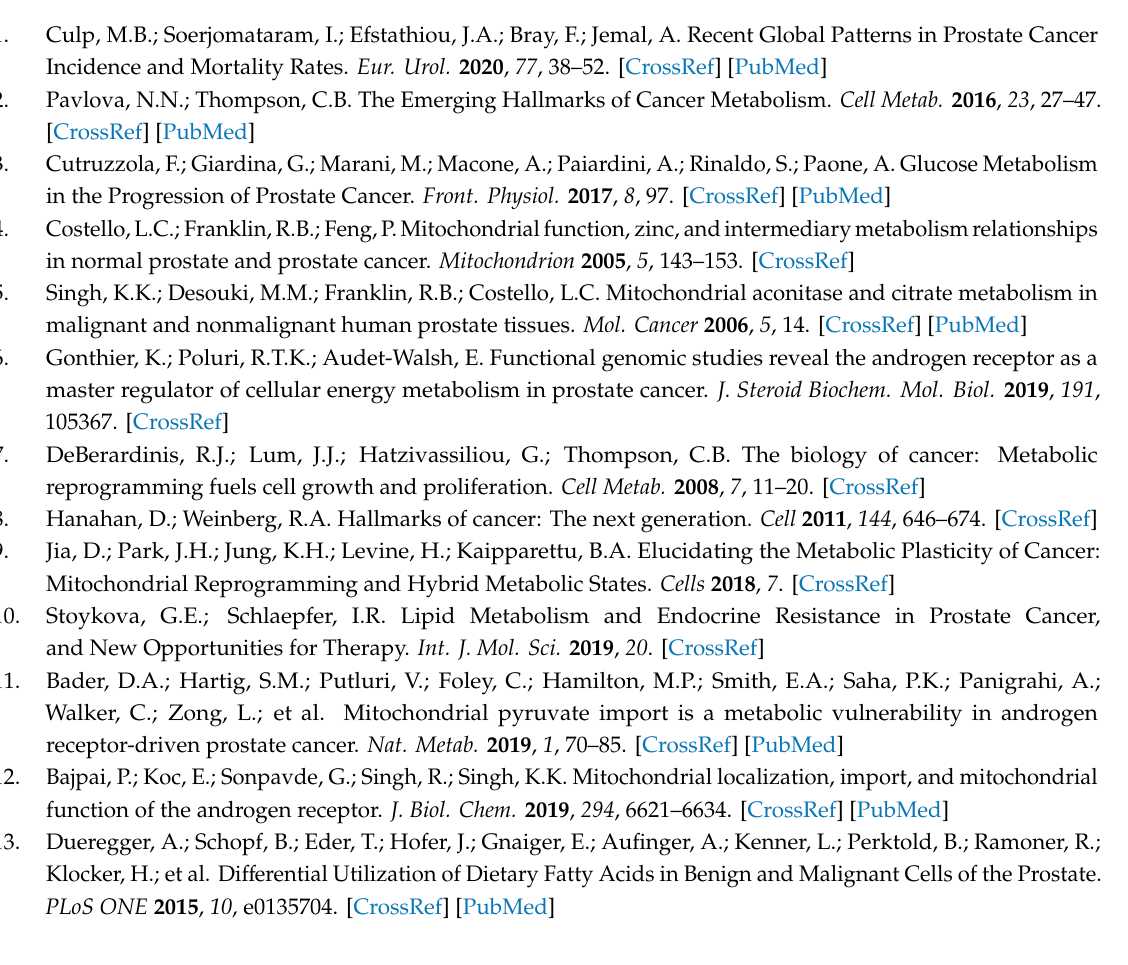
Figure S1: OXPHOS content in prostate cancer cells, Figure S2: IMMP2L content, Figure S3: mGPDH native forms in LNCaP cell line. Title, Table S1: mGPDH dependent